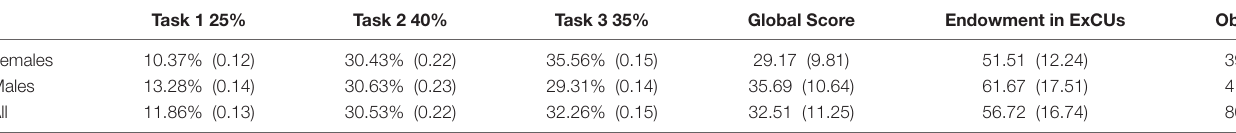
TABLE 4 | Average error rates, global score, and final endowment in the real-effort tasks, by gender.